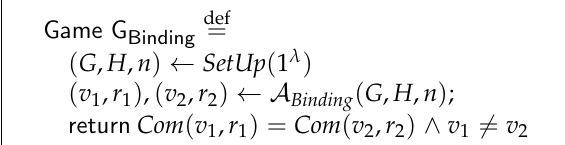
Figure 1. Game Binding